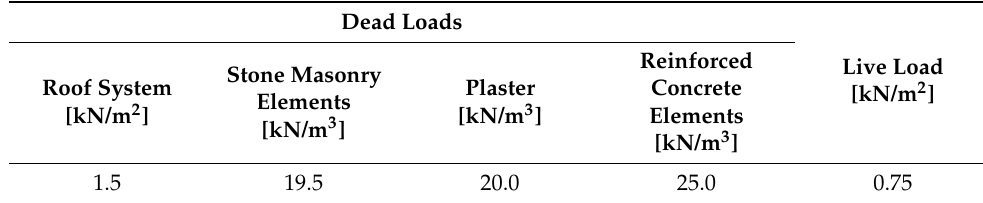
Table 4. Dead loads and live